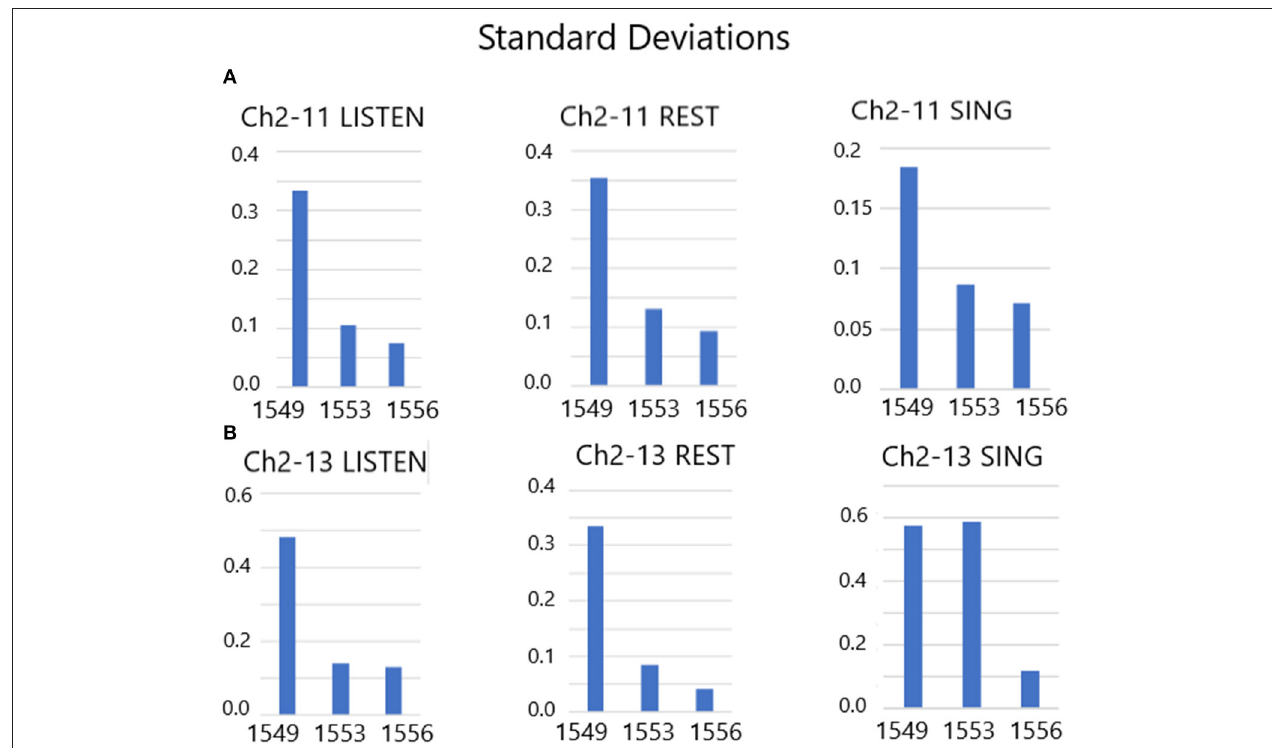
FIGURE 8 | (A,B) Standard deviations of Listen, Rest and Sing average firing rates from days 1,549, 1,553 and 1,556. These results indicate a drop in the standard deviation of firing rates during audible feedback conditioning compared with no